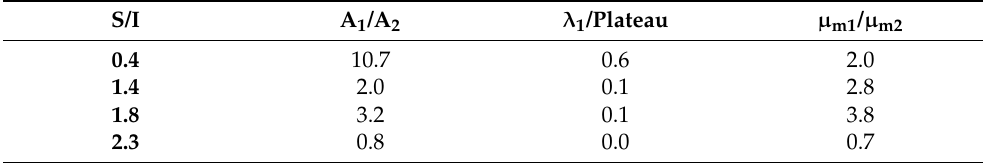
Table 2. Ratios of the parameters of the two-phase Gompertz model for trials with diauxie behaviour. S/I A 1 /A 2 λ 1 /Plateau µ m1 / µ m2